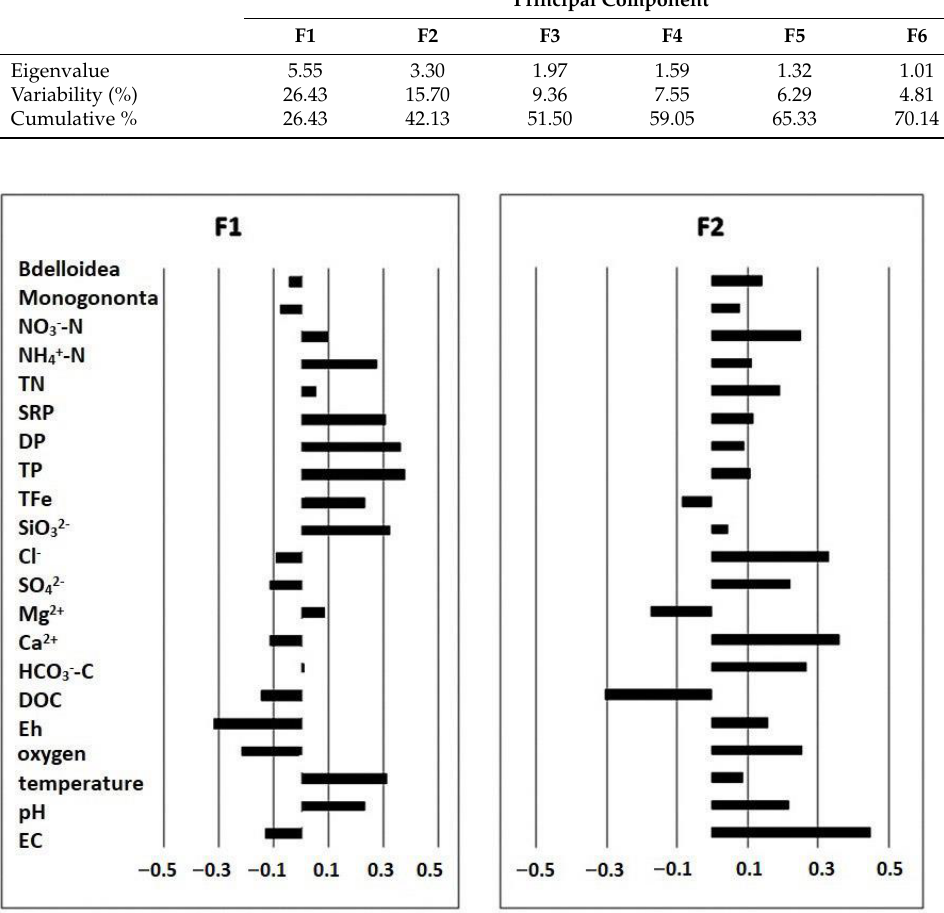
Figure 5. Eigenvectors of individual water quality parameters for Factor 1 and Factor 2 of PCA anal- ysis.